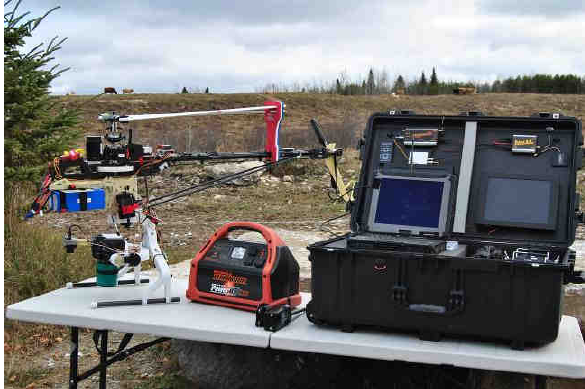
Figure 3. Ground control station and unmanned aerial vehicle used in this study (Responder, ING Robotic Aviation).